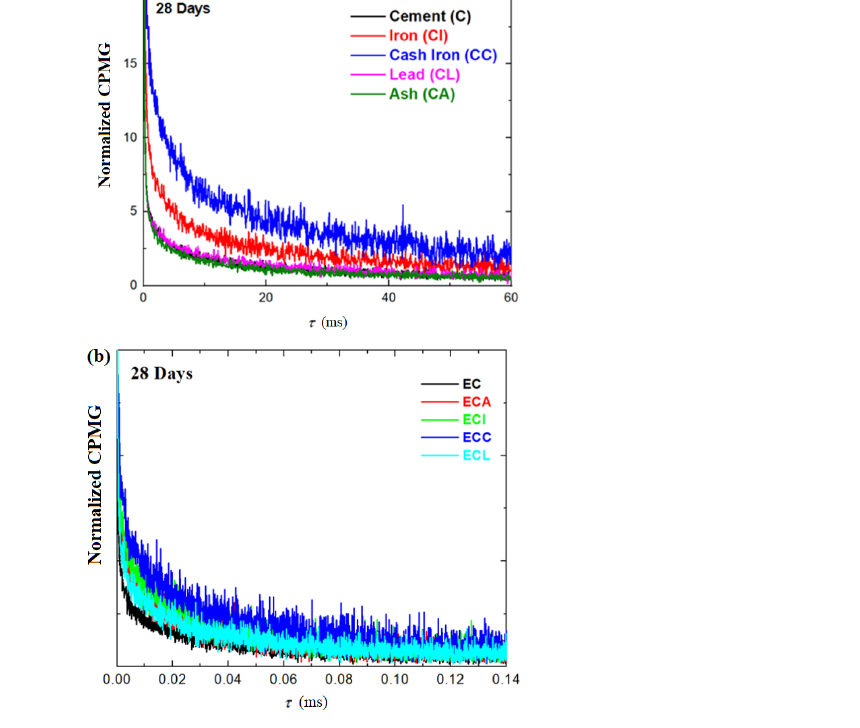
Figure 6. Normalized CPMG echo decay of ( a ) cement and composite-cement materials and ( b ) expired cement and composite-expired cement materials performed at 28 days after their preparation.